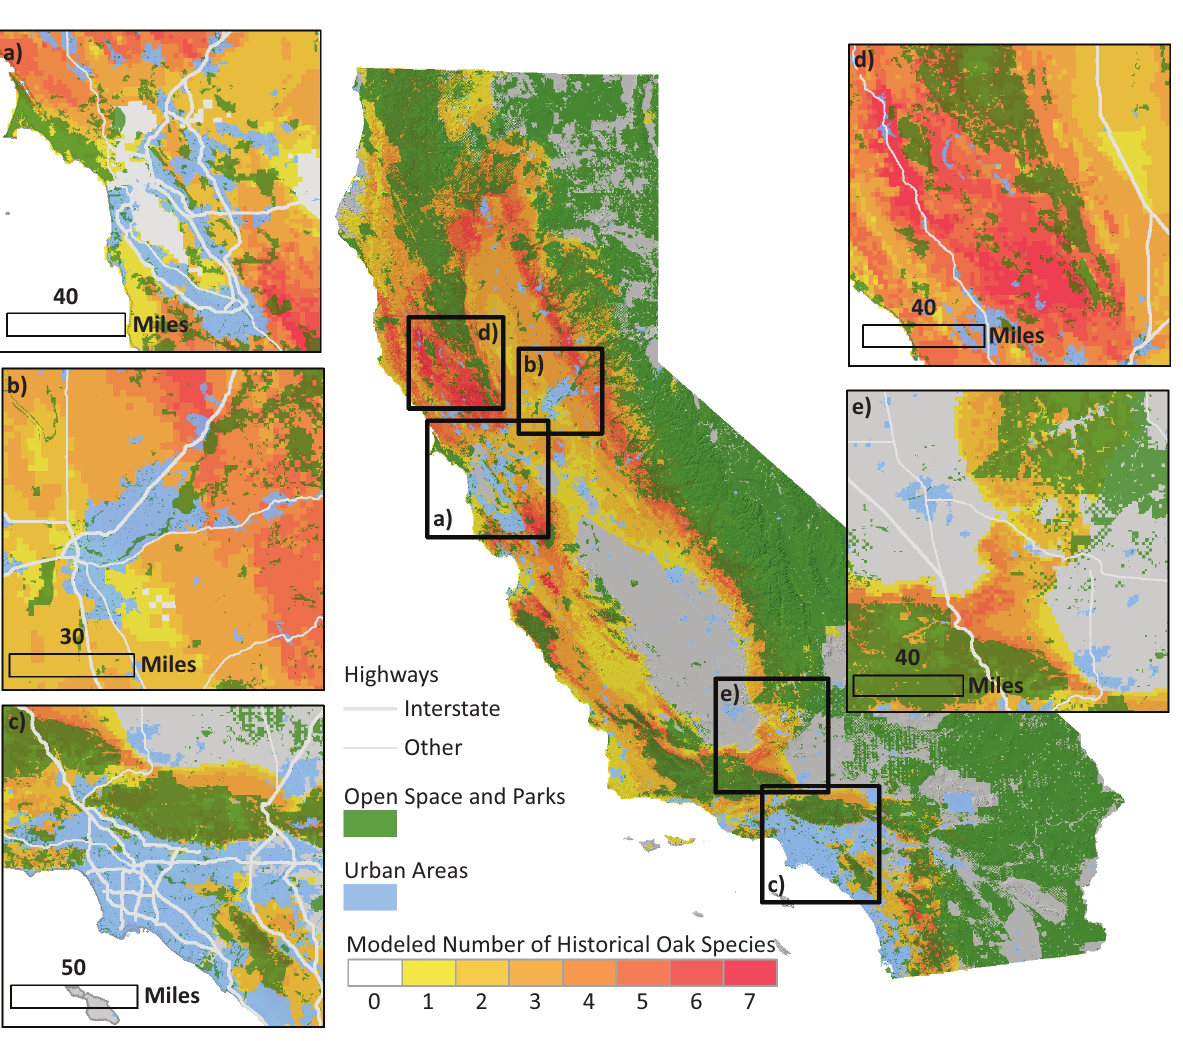
Figure 3. Areas of historical Quercus richness mapped with current urban and protected areas, with a focus on juxtaposi- tion of historical oak richness and urban areas: a) San Francisco Bay Area, b) Sacramento/Sierra Foothills, c) Los Angeles; as well as areas where historical oak richness are not near protected areas: d) Napa/Sonoma/Mendocino Counties and e) Tehachapi